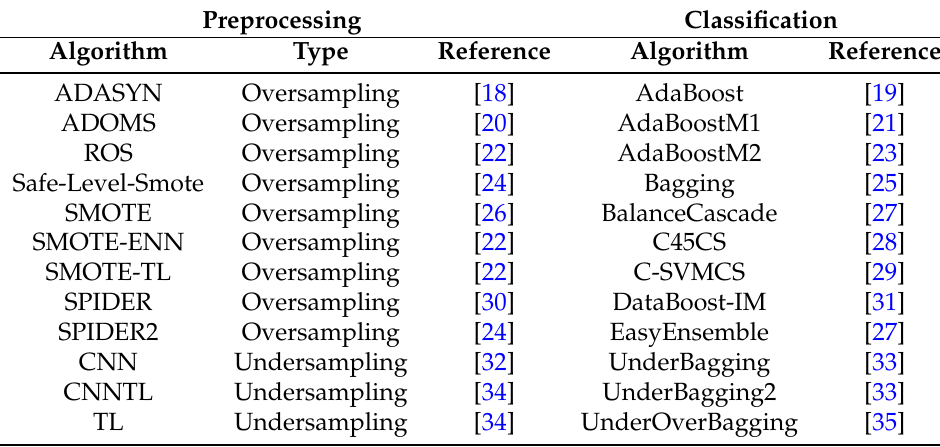
Table 1. Techniques of imbalanced